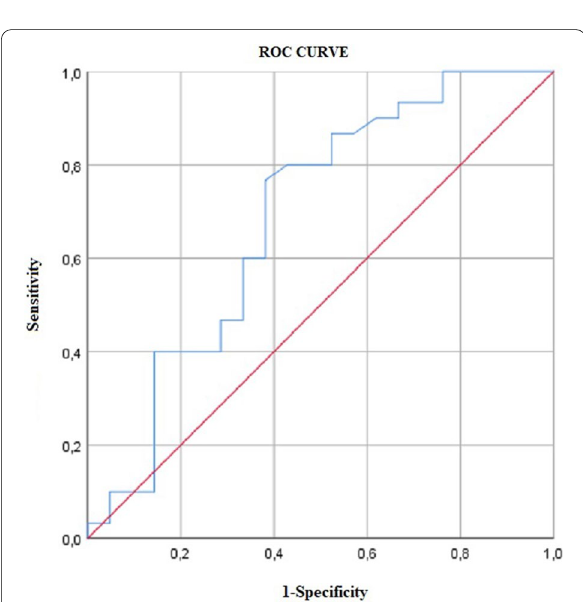
Fig. 3 ROC curve analysis between prostatitis and control group. The area under the curve (AUC) was 0.686 (95% CI 0.529–0.843) for LL37 ( p =